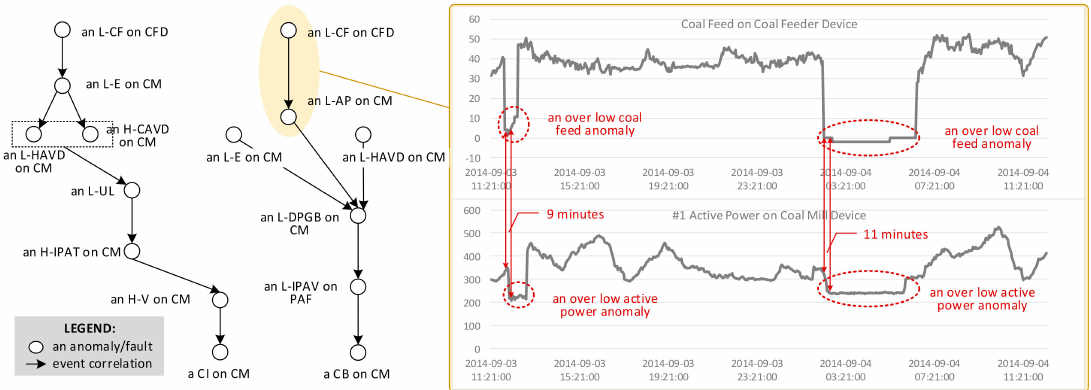
Figure 1. Partial anomaly propagation under correlations among sensors and devices in a coal power